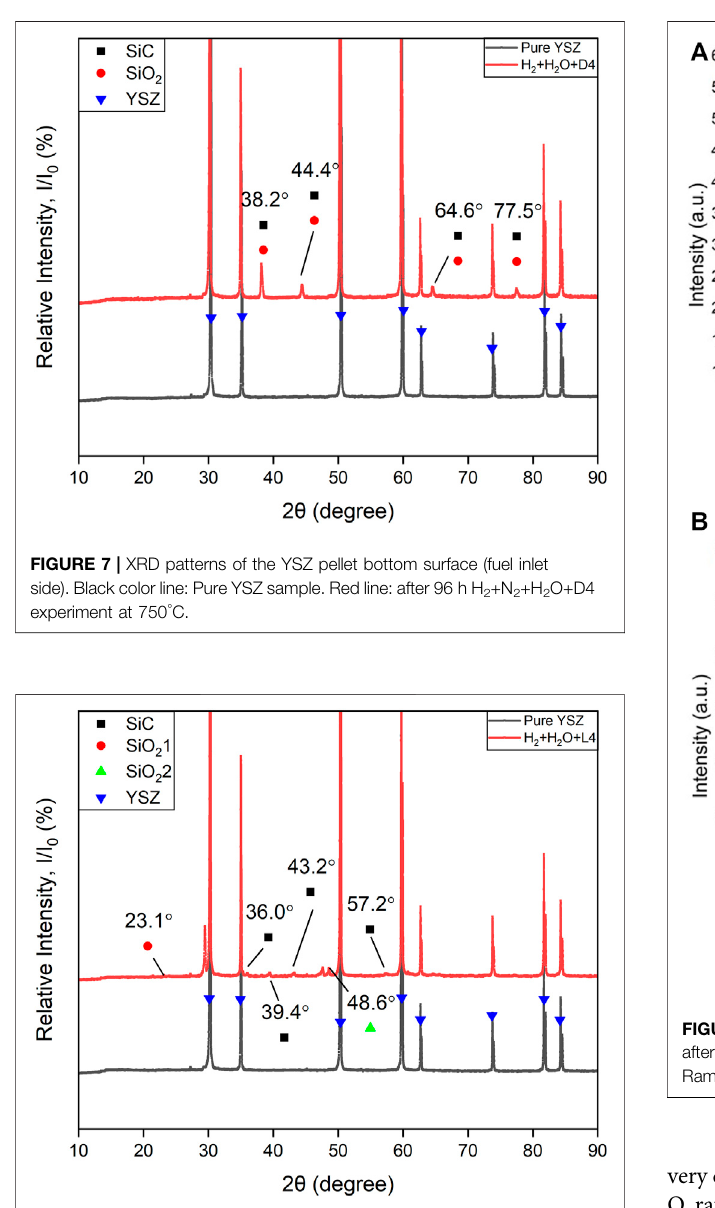
FIGURE 8 | XRD patterns of the YSZ pellet bottom surface (fuel inlet side). Black color line: Pure YSZ sample. Red line: after 96 h H 2 +N 2 +H 2 O+L4 experiment at 750 ° C.